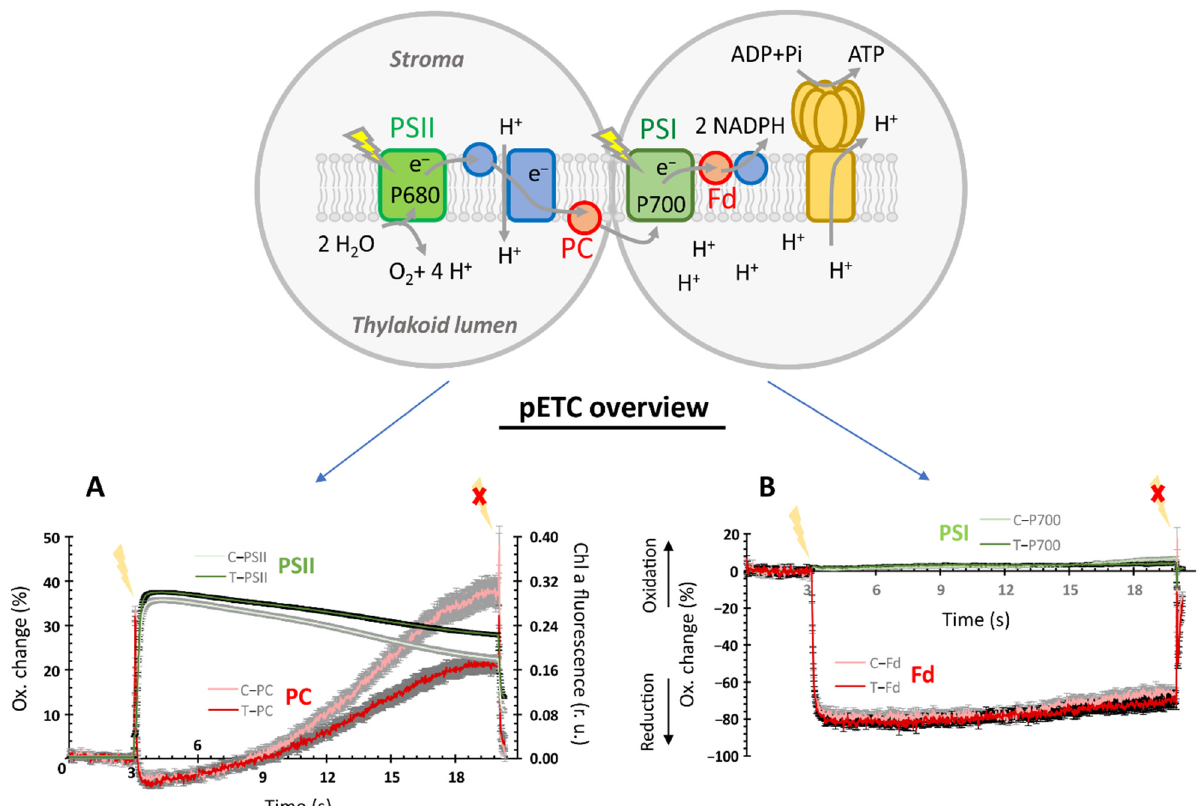
Figure 2. Effect of electromagnetic field irradiation on light-induced redox kinetics in A. thaliana photosynthetic electron transport (PET). Dark-adapted leaves of 30-day-old A. thaliana (Col-0) plants, which had previously been exposed to EMF irradiation for 48 h (treatment = T, control = C) were analyzed for the light-induced kinetic redox changes in PSI (photosystem I), PC (plastocyanin), and Fd (ferredoxin). Simultaneously, the chlorophyll a fluorescence was recorded to also quantify the efficiency of PSII (photosystem II). The pictogram in the figure highlights these components and their relative position in the PET. For this analysis using Dual-KLAS-NIR (Walz, Germany), leaves were exposed to light (160 µmol photons m − 2 s − 1 ) for 17 s with simultaneous recording of the electron flow through PET. This light period was flanked by recording for 3 s in the dark before and ~300 ms afterward as presented in A and B. As indicated in the figure, ( A ) gives the major treatment-specific effects on the Chl a fluorescence and redox kinetics of PC components on the acceptor side of PSI, while ( B ) shows minor changes observed for PSI and Fd redox shifts. The given redox changes for individual components are based on deconvolution using the model spectra generated from similarly grown plants followed by scaling using the estimated pool sizes for each component.